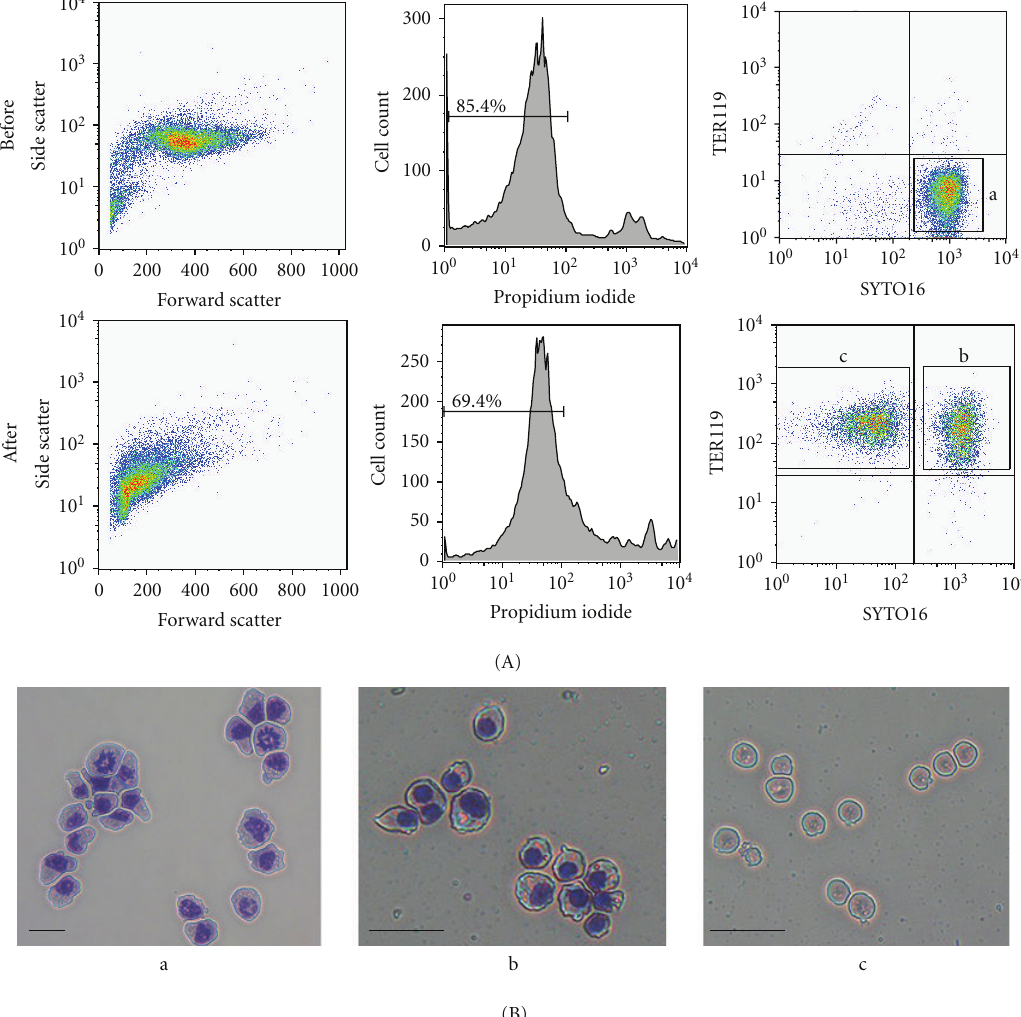
Figure 4: In vitro enucleation of a MEDEP cell line, MEDEP-BRC5. The in vitro di ff erentiation of MEDEP-BRC5 was performed as described in Figure 3. (A) Flow cytometric analyses. Before and After, the cells before and after in vitro di ff erentiation. Percentages of propidium iodide-negative viable cells are shown. TER119, see Figure 3. SYTO16, a cell membrane-permeable fluorochrome dye to stain nucleic acids. Following in vitro di ff erentiation, 52% of the cells were TER119-positive and SYTO16-negative cells, that is, the cells lacking nuclei. (B) Morphology of cells collected from the a, b, and c fractions shown in (A). Scale bars indicate 20 µ